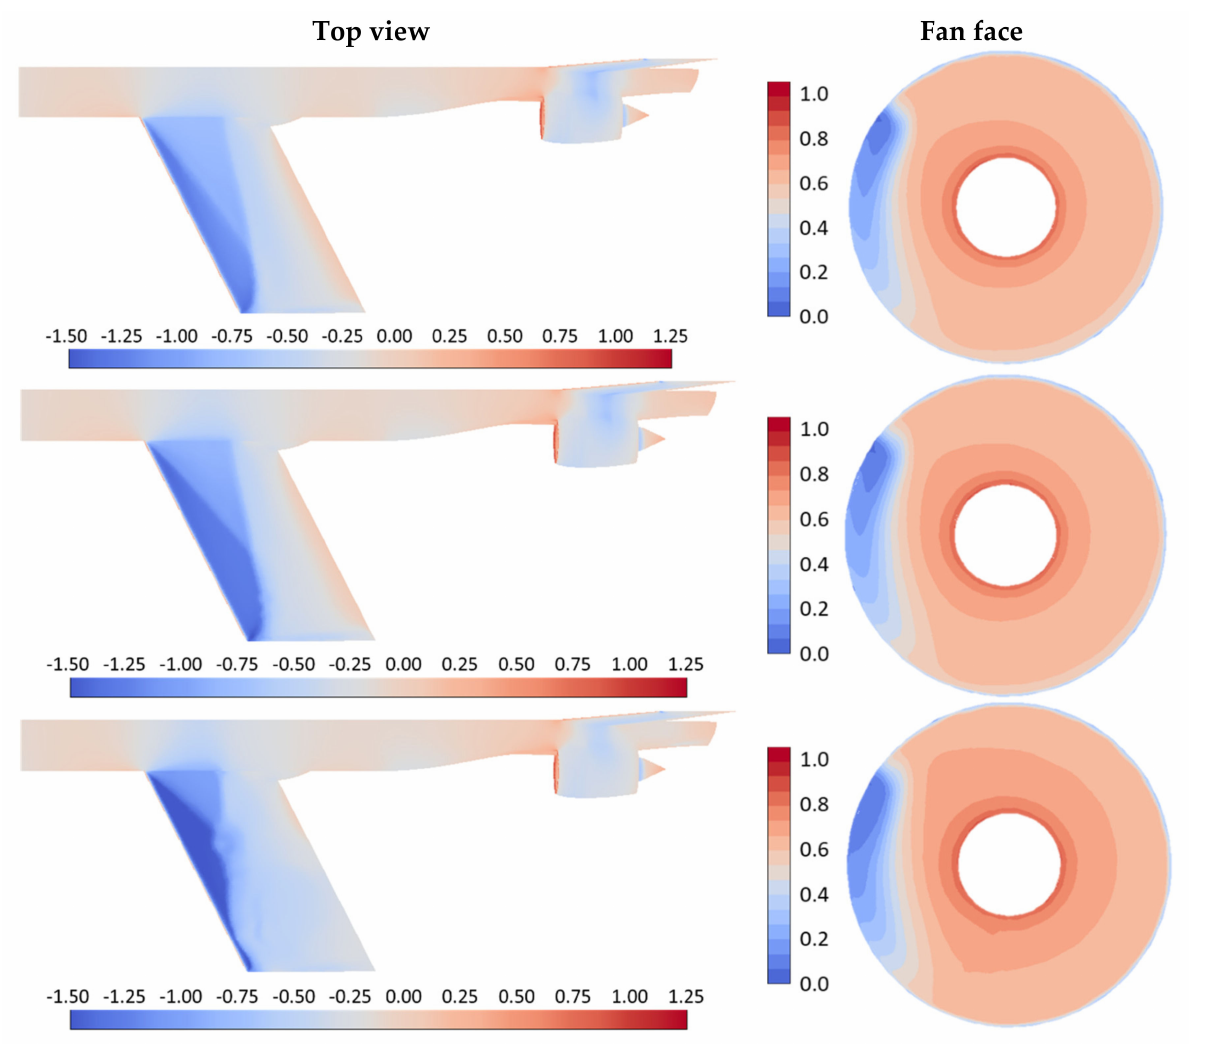
Figure 18. Contours of pressure coefficient on the aircraft body ( left ) and Mach number in the fan inlet ( right ), results from the 3D simulation of angle of attack variation cases ( from top to bottom : AOA 1 deg, AOA 2 deg and AOA 4